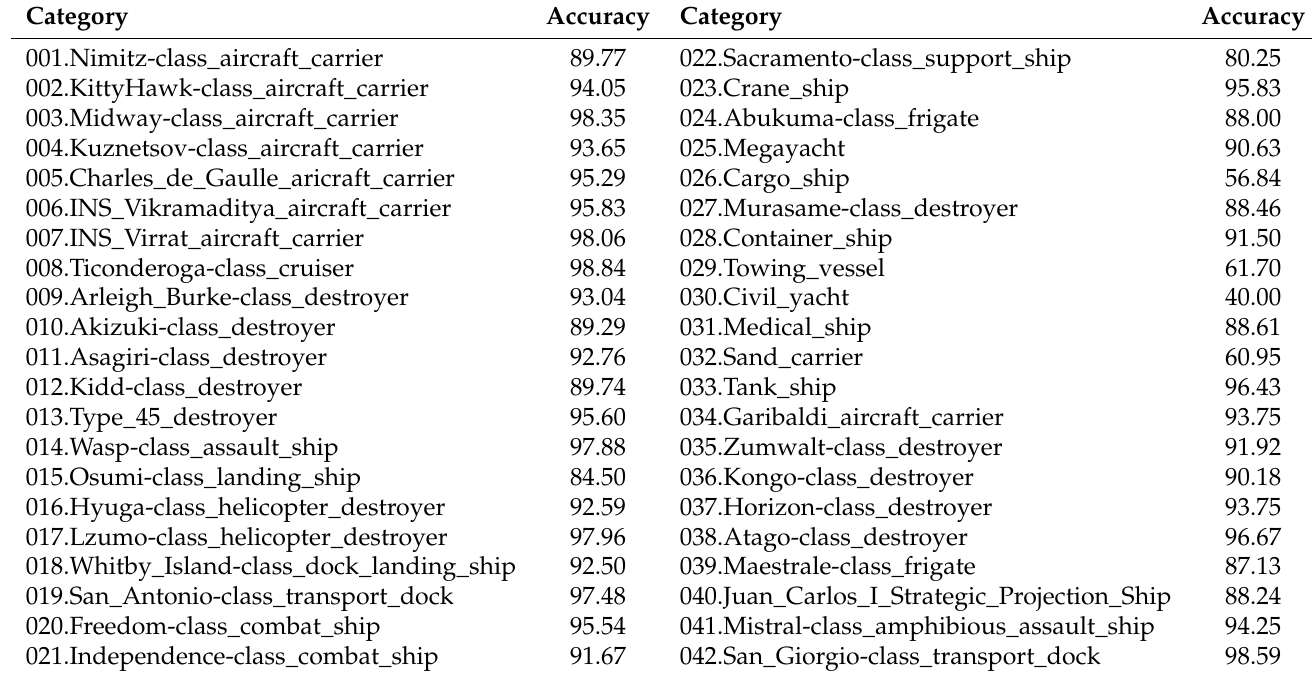
Table 5. Accuracy of each category when using the B-CNN algorithm for fine-grained classification on FGSCR-42. Category